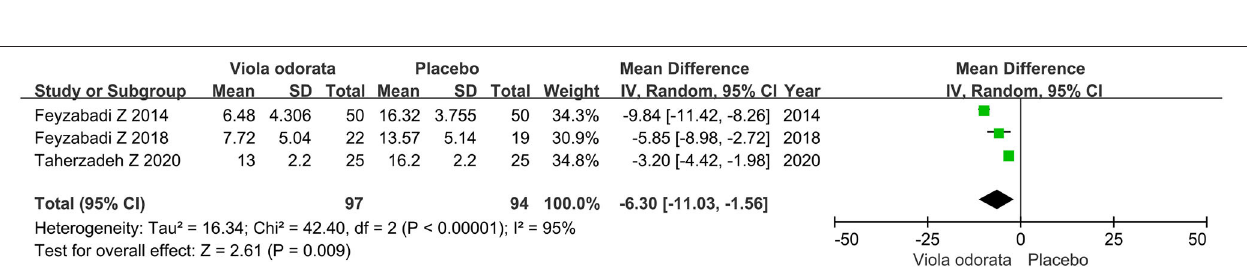
Frontiers in Neurology | www.frontiersin.org 8 June 2022 | Volume 13 | Article